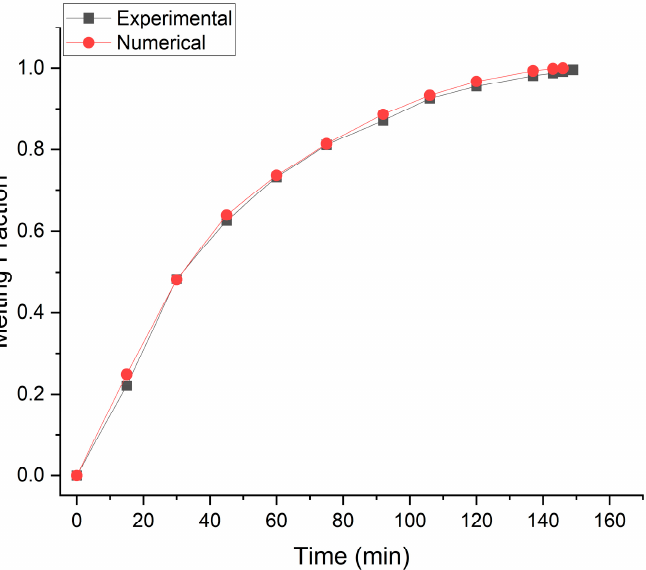
Figure 5. Numerical and experimental results comparison for fin placed at the mid